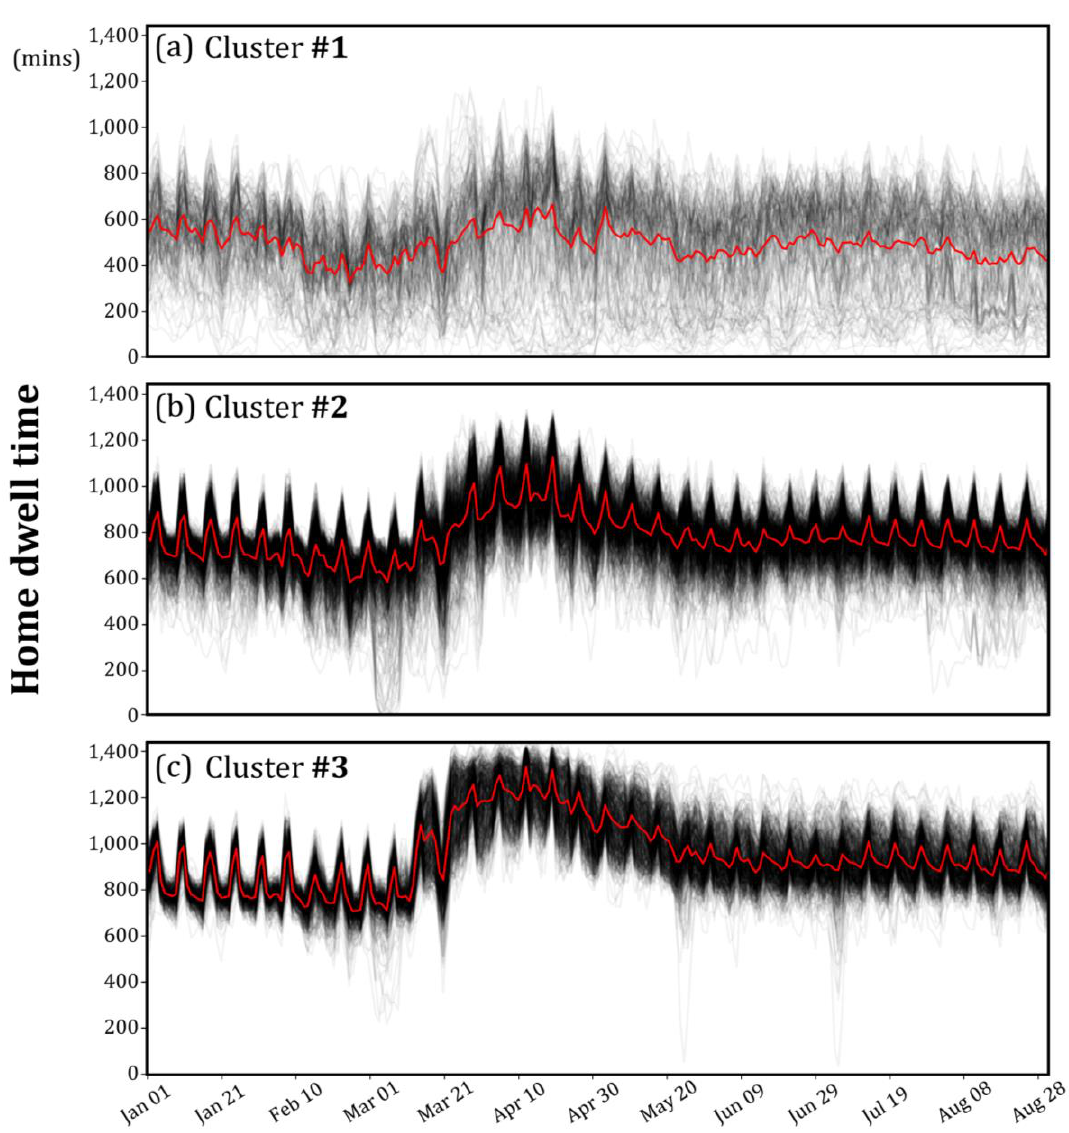
Figure 4. The time-series of the three identified CBG clusters. ( a ) Cluster #1: CBGs with unnoticeable changes in home dwell time (157 CBGs); ( b ) Cluster #2: CBGs with a moderate increase of home dwell time (778 CBGs); ( c ) Cluster #3: CBGs with a strong increase in home dwell time (552 CBGs).